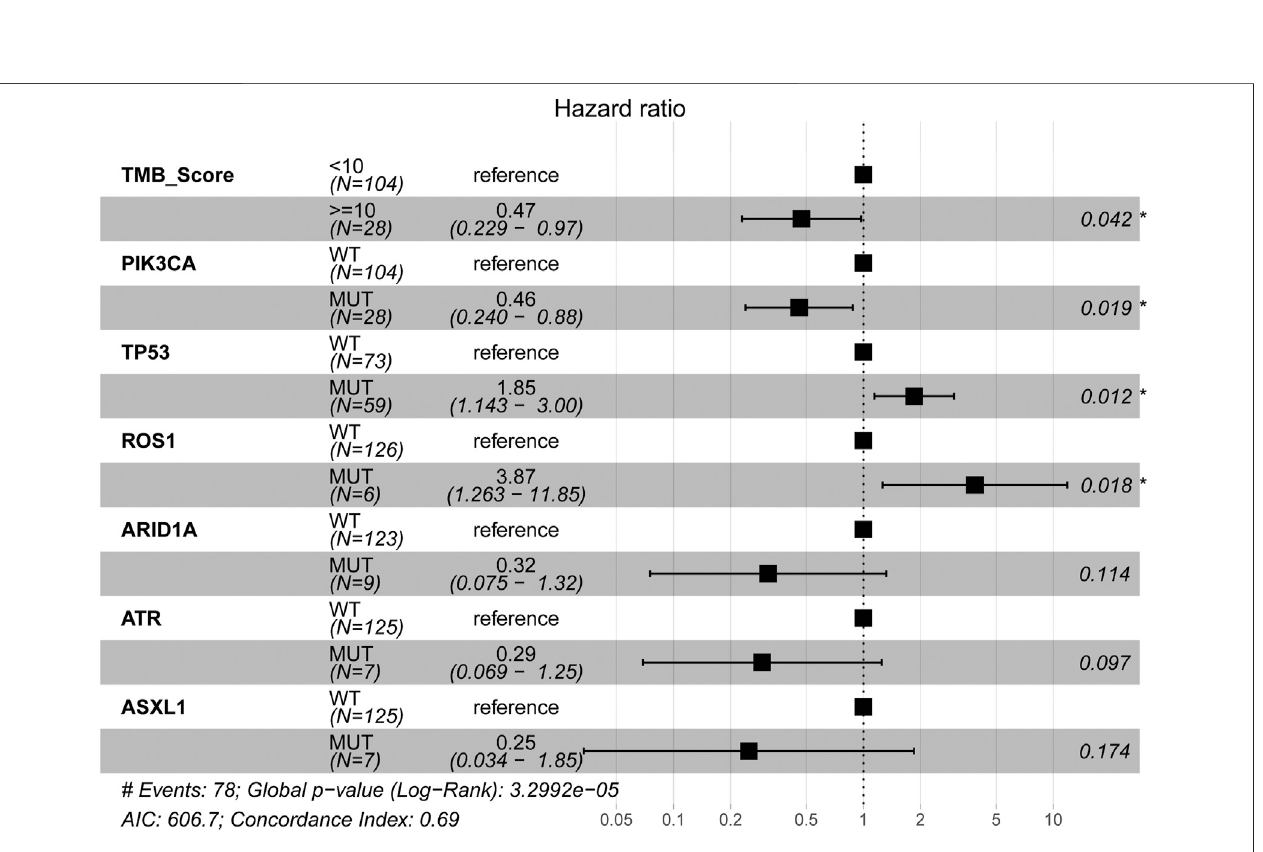
Frontiers in Genetics |